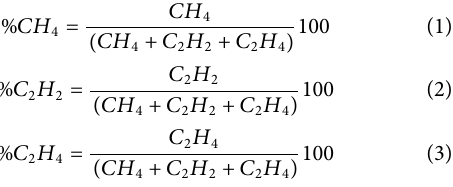
respectivelimitandassignastatusconditionbasedonwhetherlimits